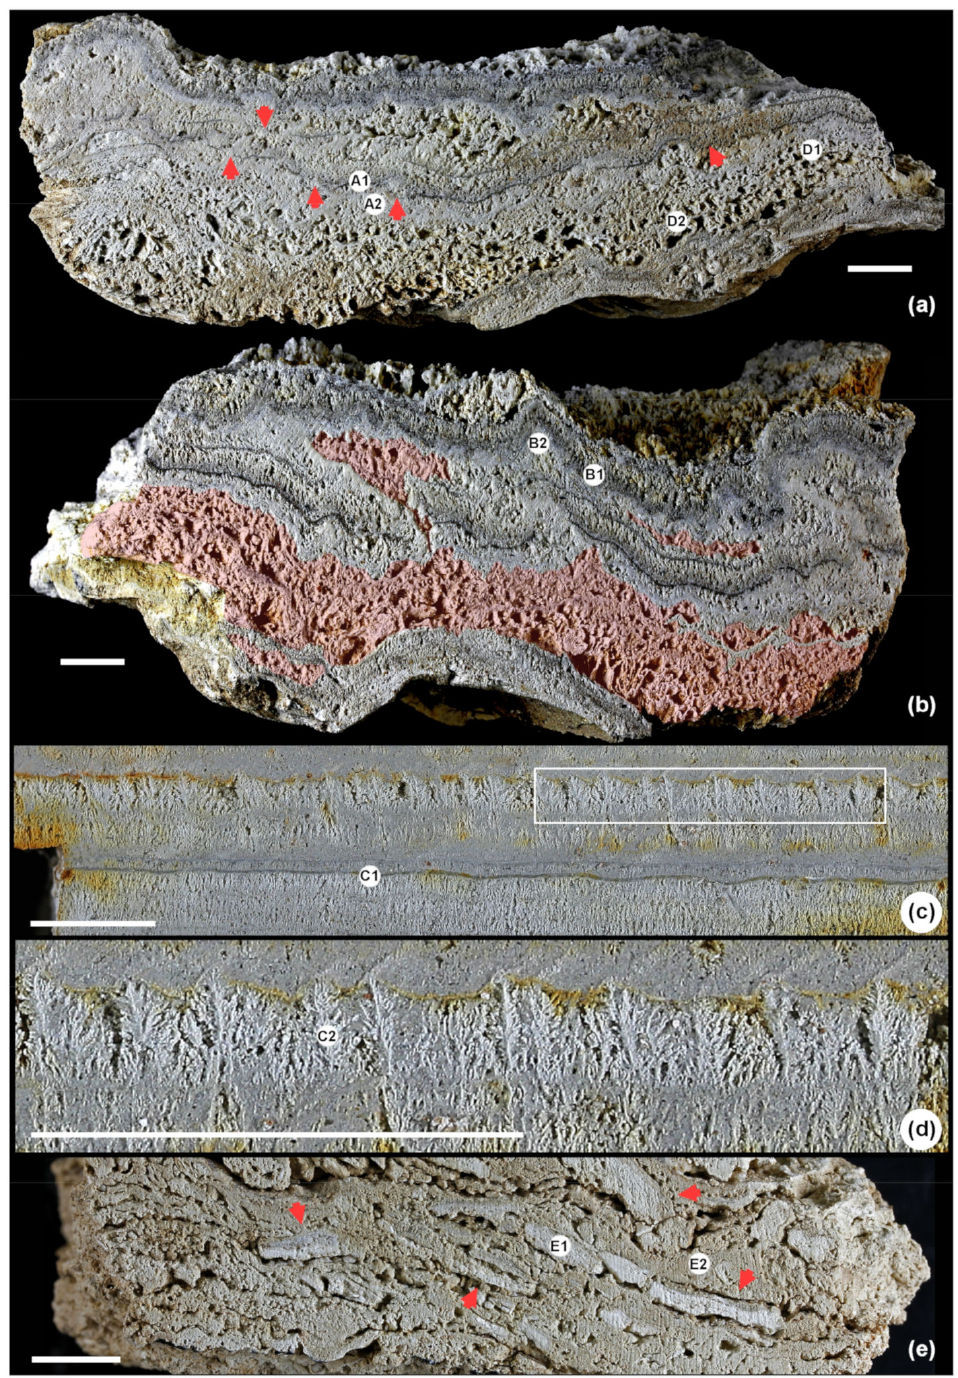
Figure 3. Polished sinter slabs from Selt ú n. ( a ) Wavy laminae (about 1 mm thick) adapting to geometry of bubble sinters (dyed red in Figure 3b) from a pool margin; well-indurated silica shows light-to-dark grey gradations (textures) and scouring contacts (red arrows) interrupting laminae; scale bar = 1 cm. ( b ) Alternating wavy laminated (with alternating light to dark grey textures) and bubble fabrics from an abandoned meander channel; scale bar = 1 cm. ( c ) Alternations of stacked palisade laminae (<1 cm thick) and well-indurated silica; scale bar = 0.5 cm. ( d ) Detail of previous image (boxed area) showing branching geometries; scale bar = 0.5 cm. ( e ) Breccia deposit of silica clasts embedded in silica crust indicating reworking of vitreous fabric sinter rocks; scale bar = 1 cm. Abbreviations: A1, A2, B1, B2, C1, C2, D1, D2, E1, and E2 mark provenance of biomarker